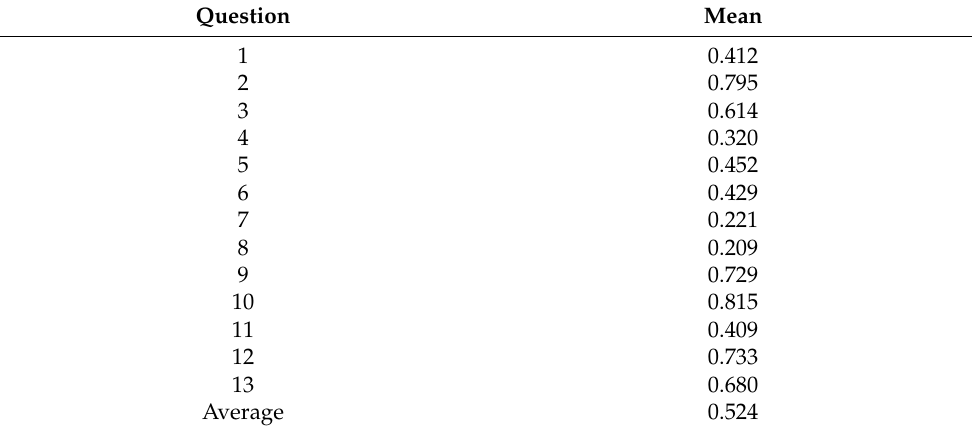
Table 3. Mean fraction of correct responses to each